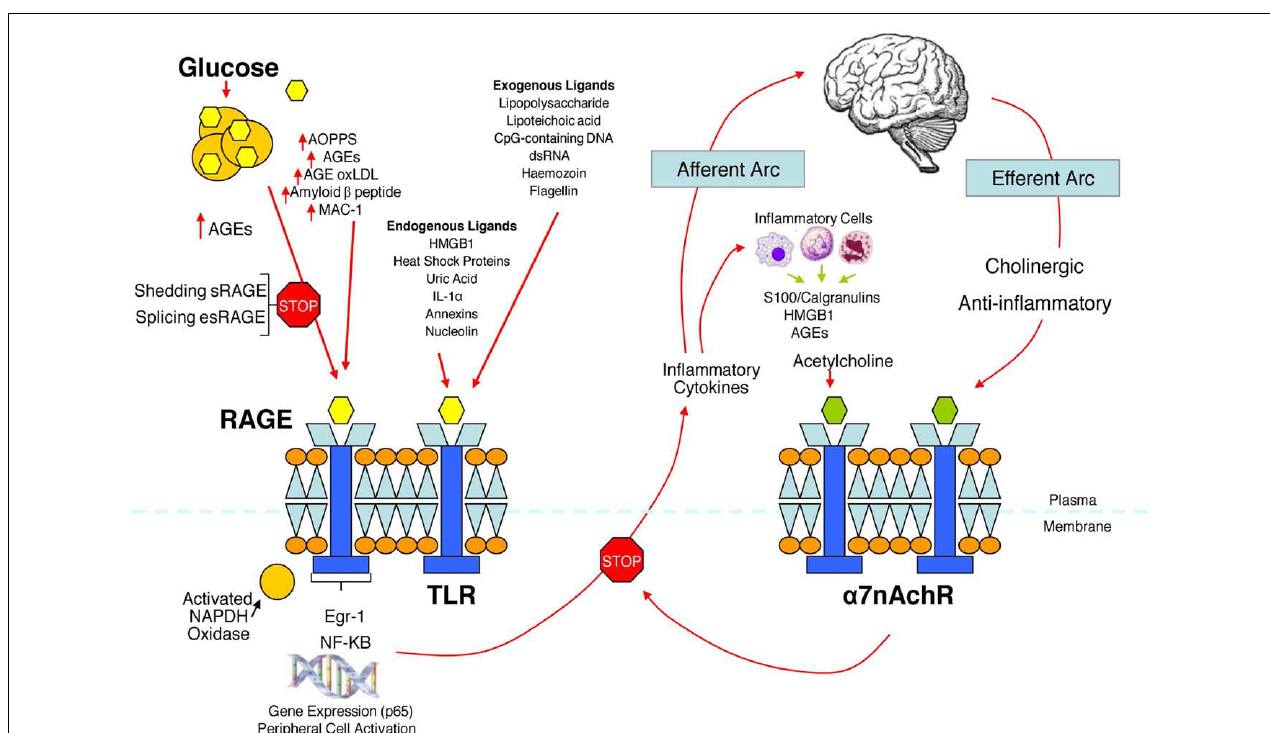
FIGURE 3 |The relationship between binding of ligands to the pattern recognitionAGE receptor (RAGE) and inflammation, gene expression, oxidative and nitrosative stress, and damage to the macro- and microvasculature. Elevated levels of glucose bind to proteins and form AGEs, which bind to RAGEs. RAGE signaling activates NADPH oxidase and production of reactive oxygen species (ROS). Increased ROS increases advanced oxidation protein products (AOPPs), more AGEs, and AGE-modification of oxidized LDLs (oxLDLs). Furthermore, increased ROS may deplete glutathione, thereby suppressing glyoxalase I activity, a mechanism favoring further AGE accumulation. AGEs, AOPPs,